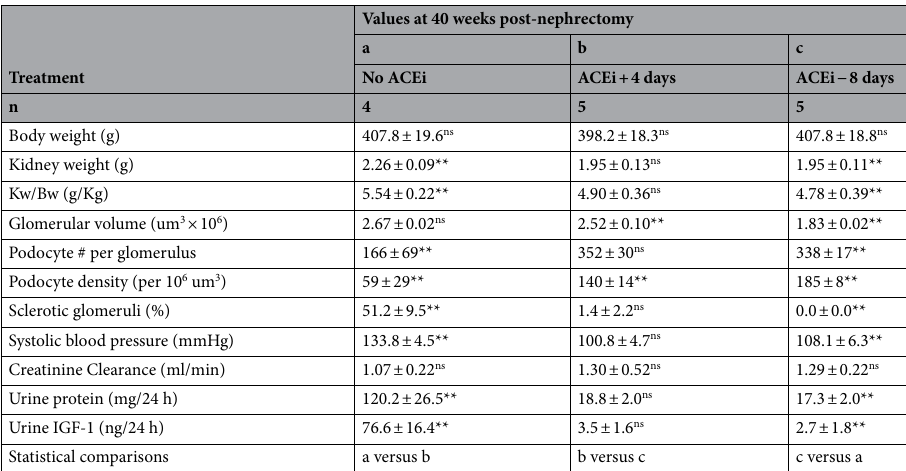
Table 1. Comparisons for the effects of ACEi started either 4 days after nephrectomy (+ 4 days) or 8 days before nephrectomy (-8 days) with non-ACEi-treated rats at 44 weeks after uni-nephrectomy. The effect of ACEi start time on long-term post-uni-Nx outcome. Starting ACEi 8-days before uni-Nx had no measurable morphometric effect as shown by GV which was 0.47 ± 0.04 um 3 × 10 6 in ACEi pre-treated rats compared to 0.46 ± 0.05 um 3 × 10 6 or 0.48 ± 0.05 um 3 × 10 6 in rats started on ACEi either 4 days after uni-Nx or in non- ACE-treated rats respectively. Similarly, the podocyte number per glomerulus and podocyte density were not different between the group pre-treated with ACEi versus those that were not pre-treated with